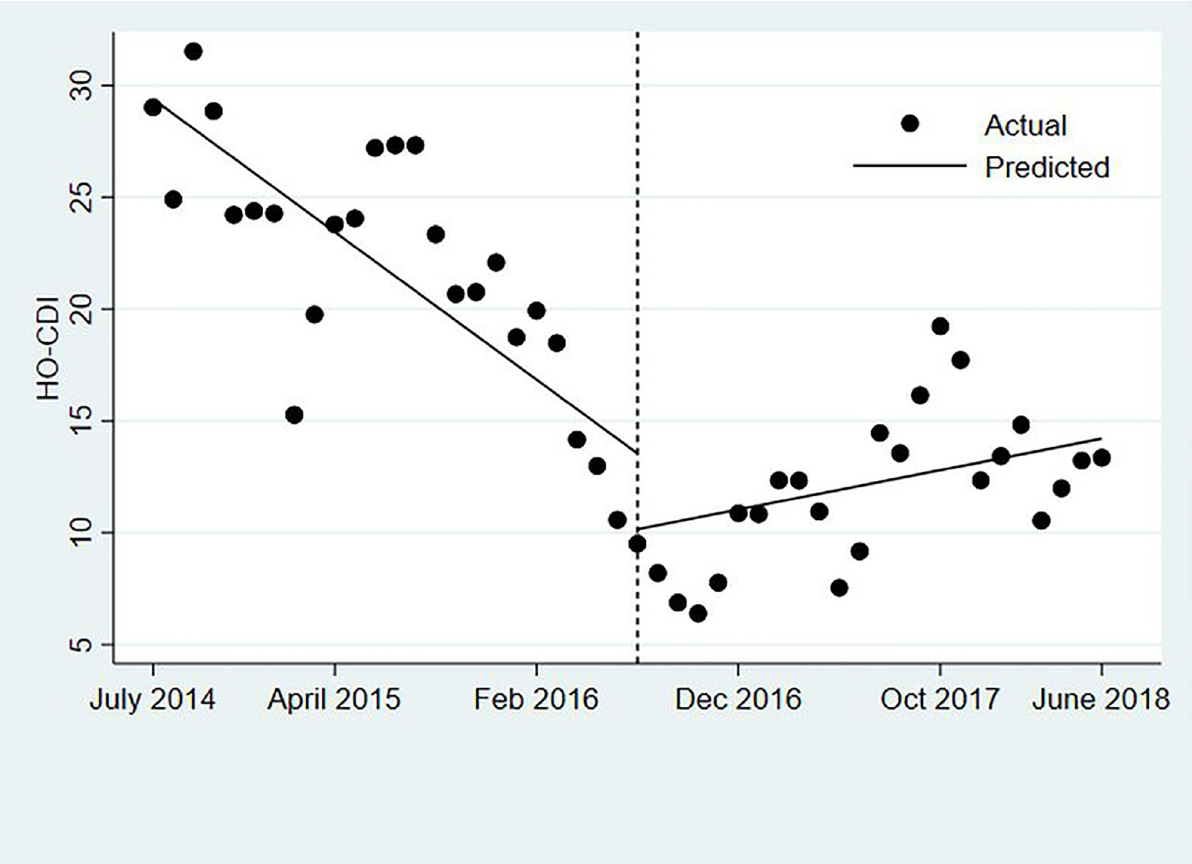
Fig 1. Interrupted time-series analysis, hospital-onset Clostridioides difficile infection.